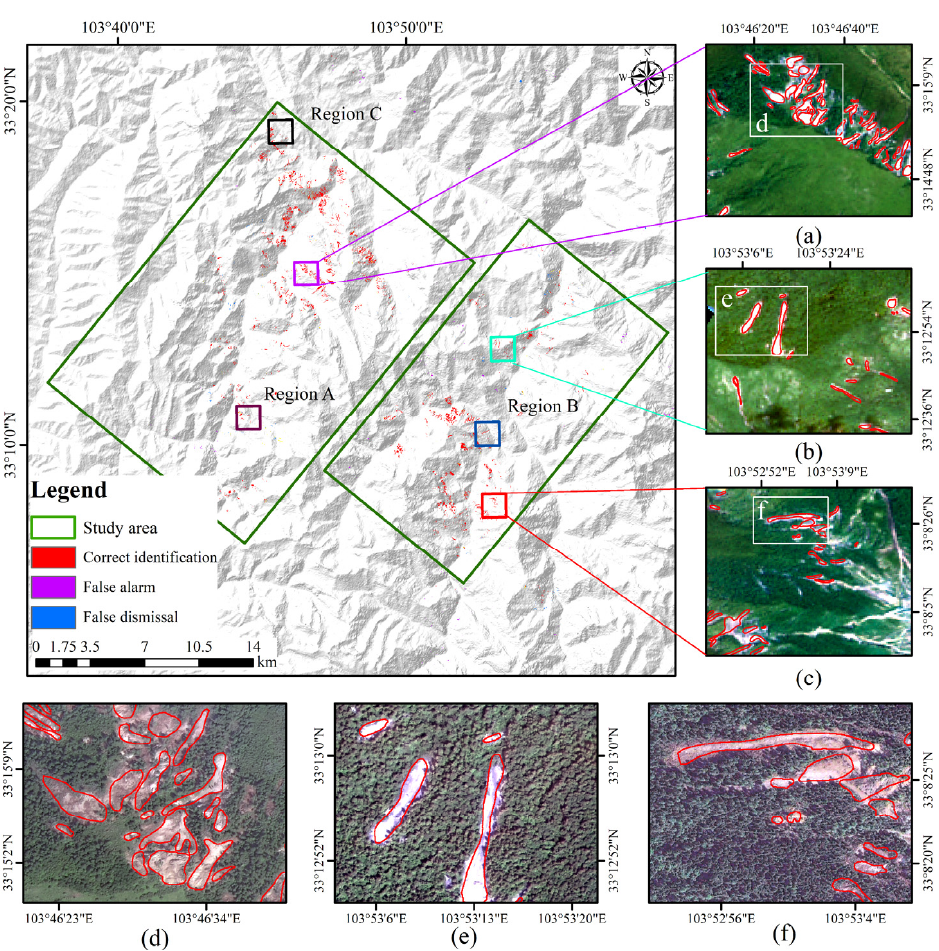
Figure 6. Recognition results of the proposed EGCN. Regions A, B, and C and subfigures ( a – c ) are six subregions in the testing set. ( d – f ) are the subparts of ( a – c ), respectively.